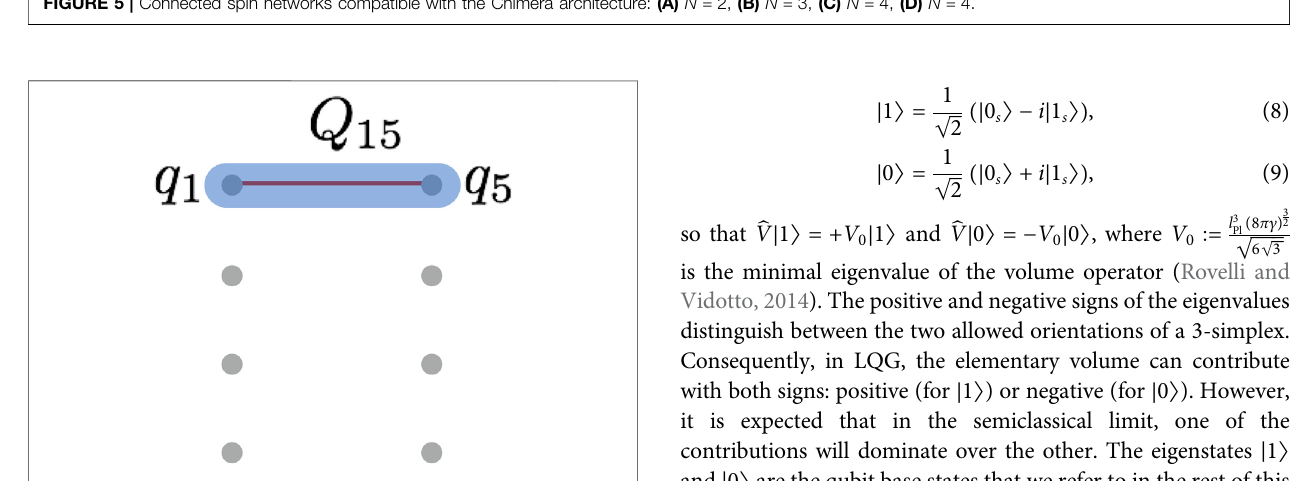
FIGURE 5 | Connected spin networks compatible with the Chimera architecture: (A) N (cid:2) 2, (B) N (cid:2) 3, (C) N (cid:2) 4, (D) N (cid:2) 4.